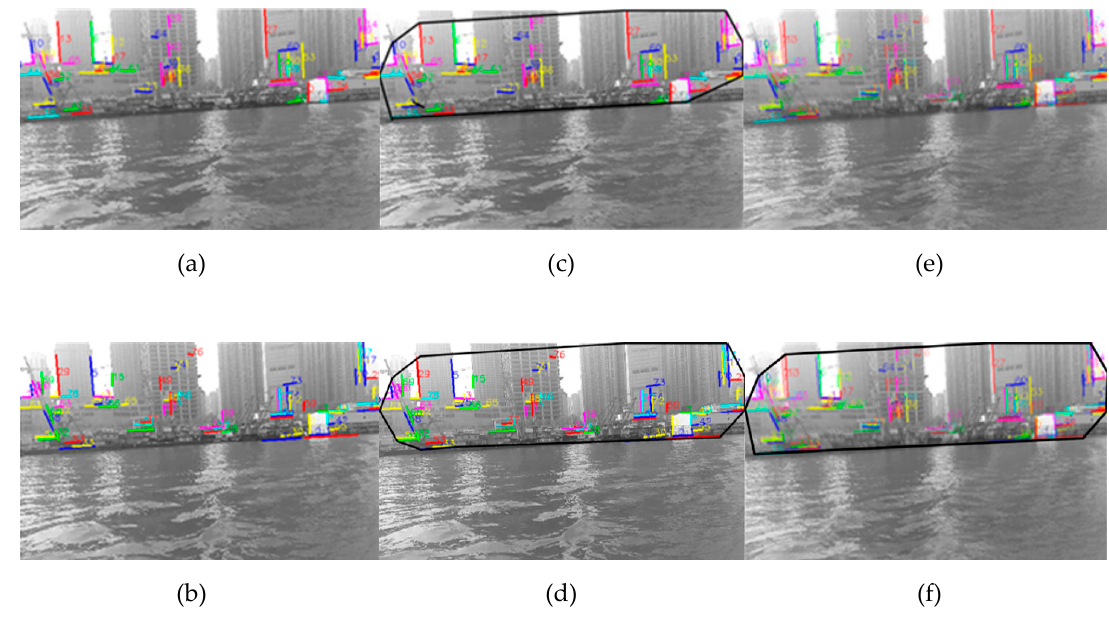
Figure 10. The shore area is generated by the image sequence: ( a ) the onshore line segment pool at t i time using t i time to t i + n time, ( b ) the onshore line segment pool at t i − m time using t i − m time to t i time, ( c ) the shore area corresponding to Figure 10a, ( d ) the shore area corresponding to Figure 10b, ( e ) the onshore line segment pool at T i time combined with Figure 10a,b; ( f ) the shore area corresponding to Figure